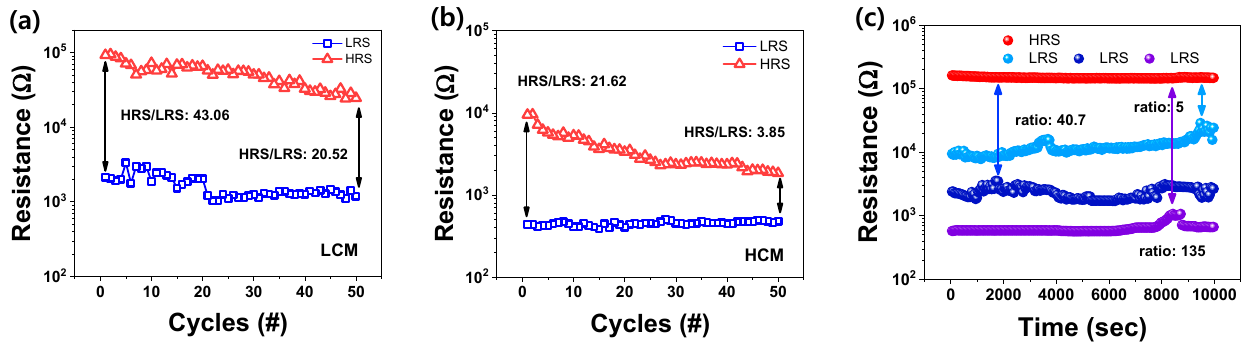
Figure 4. Endurance in ( a ) LCM and ( b ) HCM. ( c ) Retention of four levels controlled by CC at set switching.